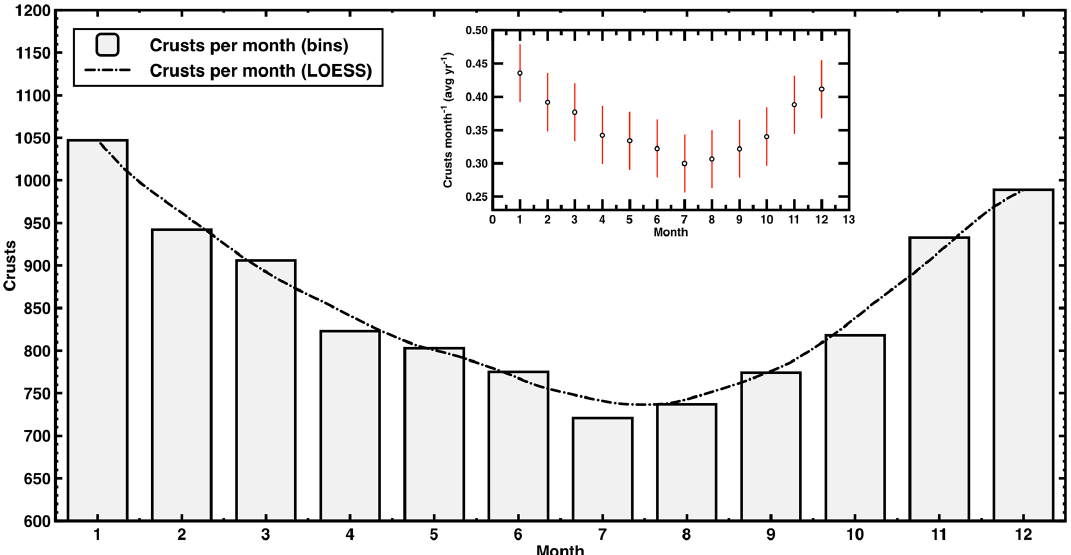
Figure 16. Crust distribution by month (1: January; 2: February; ...; 12: December) based on the assumption that each summer pick in the WD2014 depth–age scale is 1 January, and then interpolating linearly. Crusts occur year-round but more commonly in summer accumulation. The smoothed curve is a 1st-order LOESS trend curve (width = 2). Data shown for 2400-year record. Inset shows average crusts per month ( ± 1 σ ).